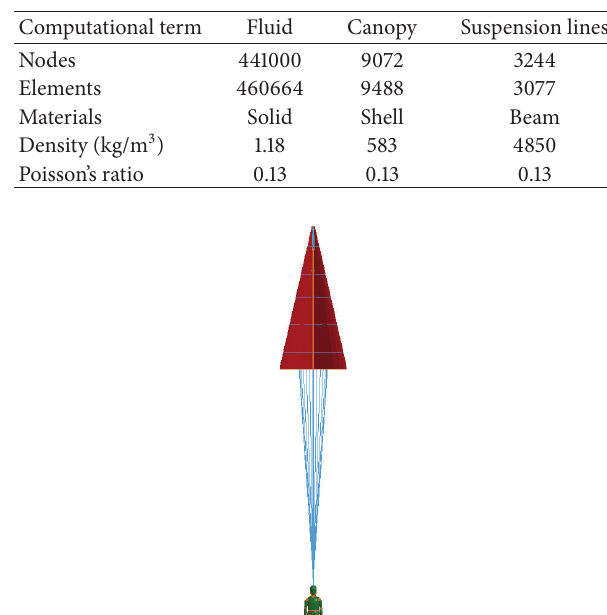
Table 1: Statistical information of FSI models.